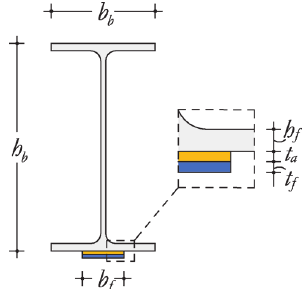
Figure 2: Cross section of the strengthened beam.